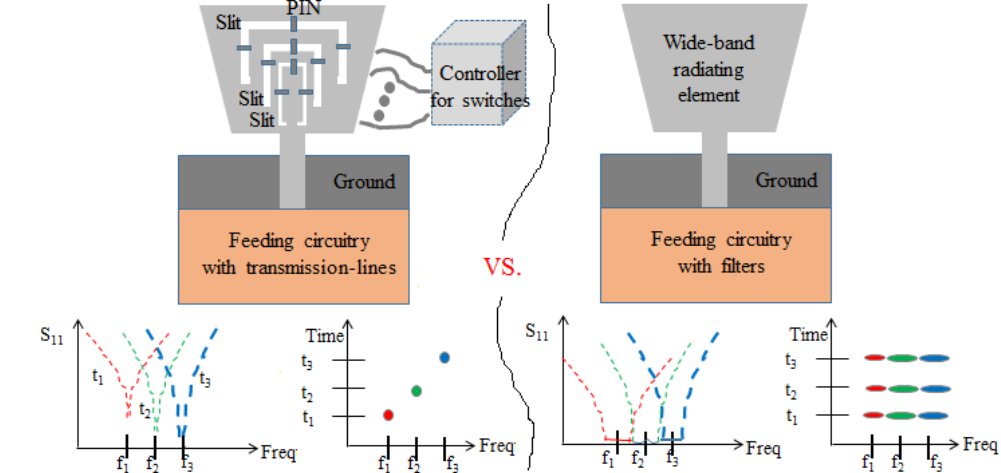
Figure 2. Two schemes of channel selection: switch-loaded RX antenna with the ordinary feed ( Left ), and non-active device loaded RX antenna with the multiplexer feed circuit ( Right ).